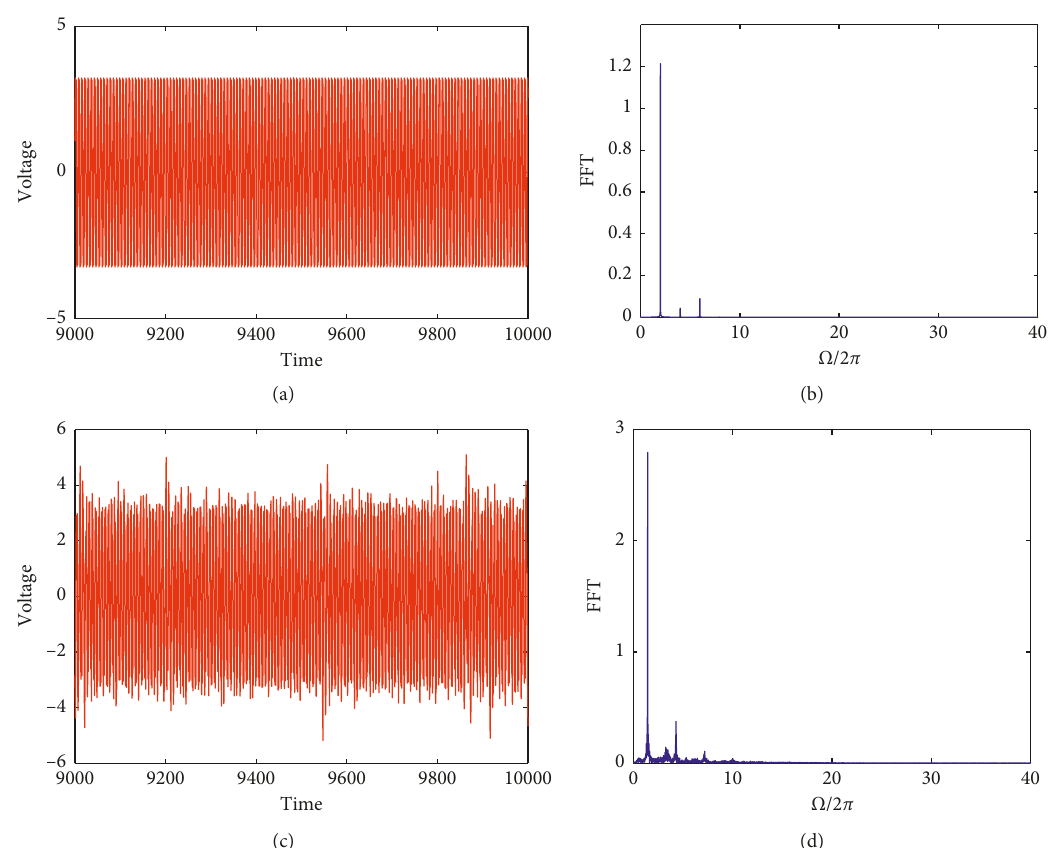
Figure 9: Response of the energy harvester for Ω � 1 . 8: (a) time-domain output voltage for c � 0 . 0; (b) spectrum of the time-domain output voltage for c � 0 . 0; (c) time-domain output voltage for c � 0 . 1; (d) spectrum of the time-domain output voltage for c � 0 . 1.